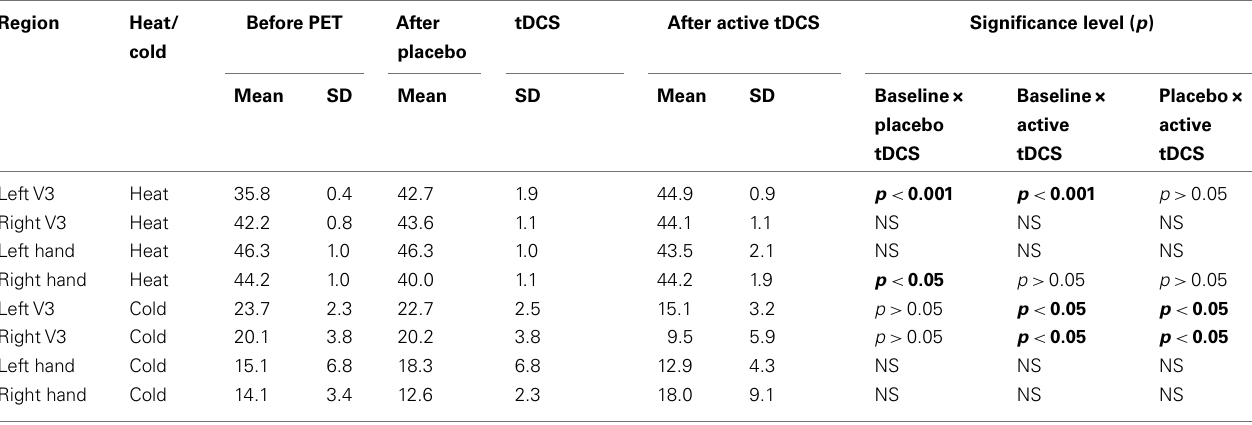
Table 1 |Variations in the heat and cold thresholds related to placebo and active